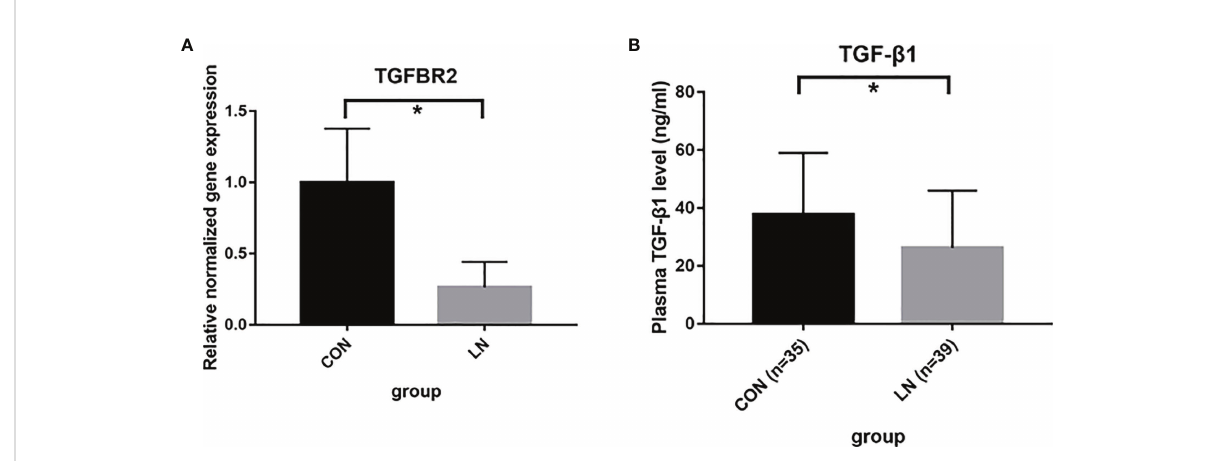
FIGURE 4 Detection of TGFBR2 and TGF- b 1 in TGF- b signaling pathway. (A) mRNA expression of TGFBR2 in renal tissue of 3 MRL/lpr mice (LN) and 3 BALB/c mice (control) assessed by qRT-PCR. (B) the plasma levels of TGF- b 1 in 39 LN patients and 35 healthy controls assessed by ELISA. * P<0.05